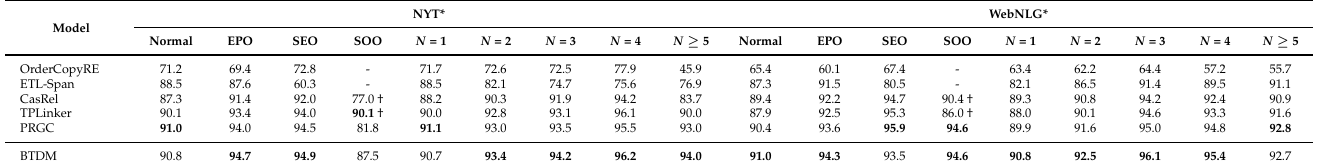
Table 3. F1-score (%) of relational triple-extraction with different overlapping patterns. Note that † marks results reported by PRGC, and Bold marks the highest score in the